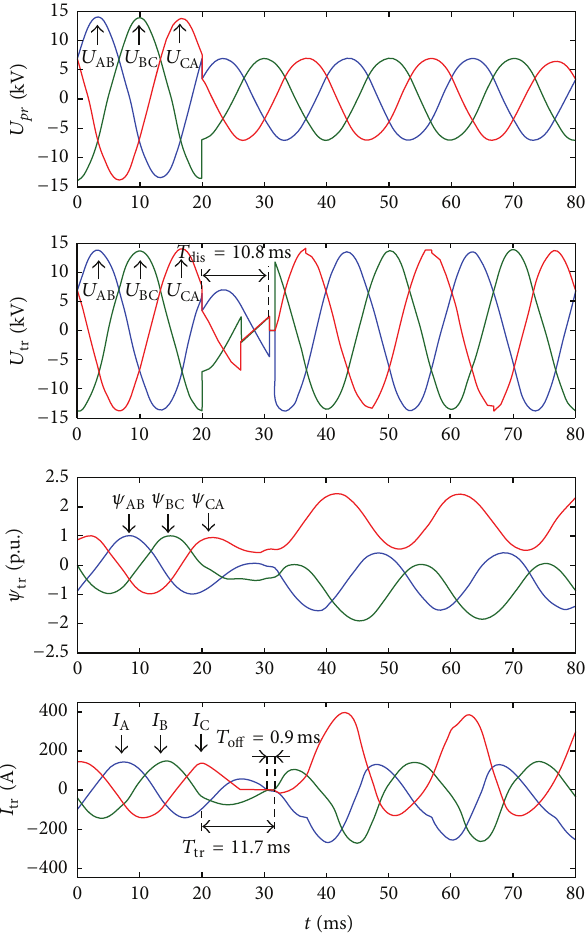
Figure 10: Waves of the transfer strategy without flux linkage DC component elimination (three-phase voltage sag). From the top to bottom, prefer source voltages, transformer voltages, transformer flux linkages, and load